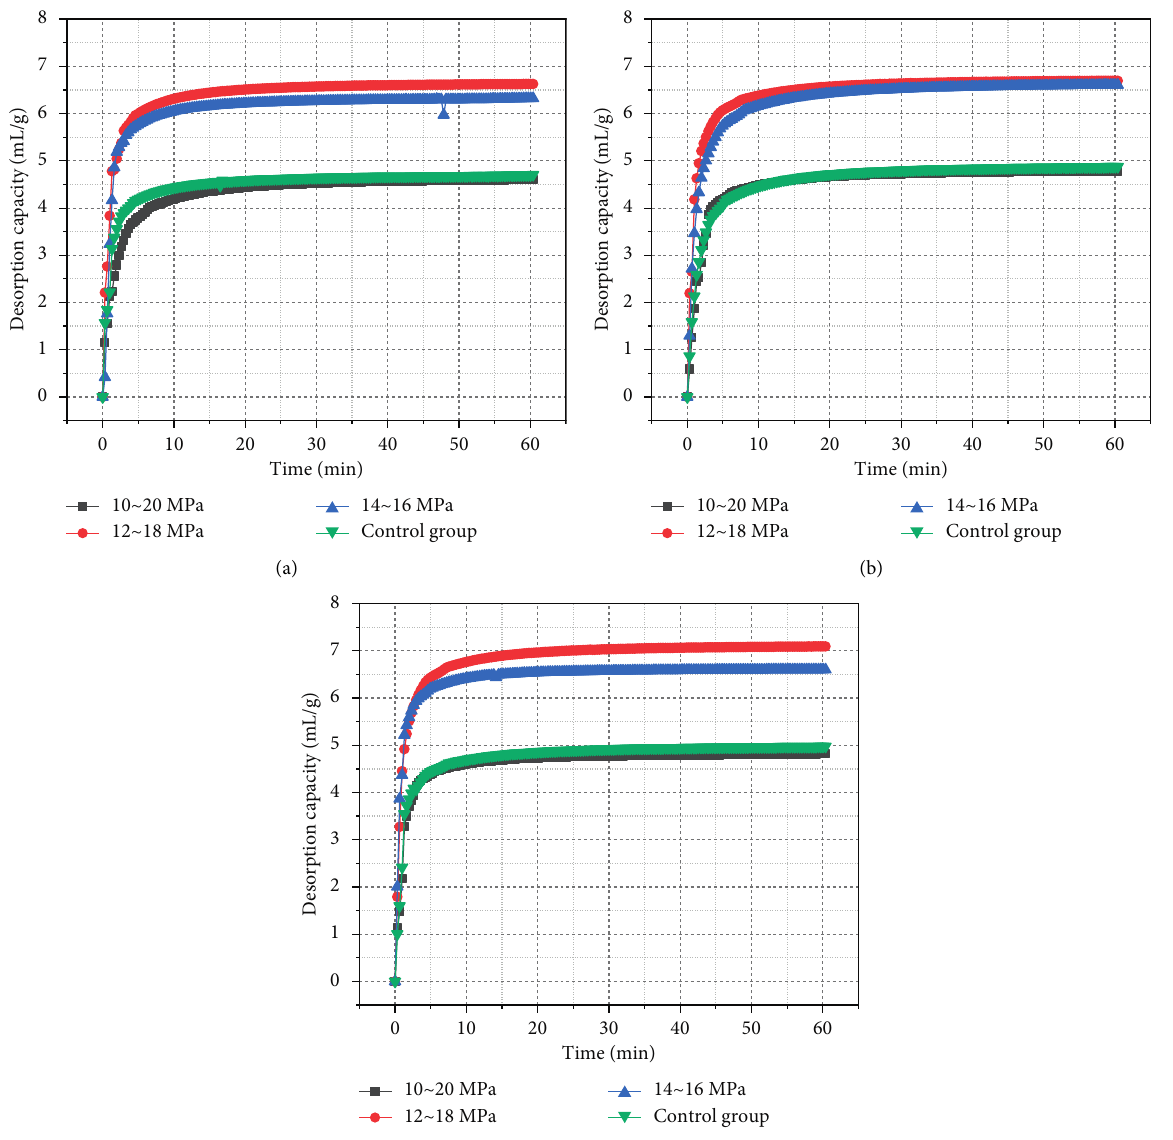
Figure 3: Desorption curves of the samples under different loading amplitudes. (a) Equilibrium pressure of 0.5MPa. (b) Equilibrium pressure of 1.0 MPa. (c) Equilibrium pressure of